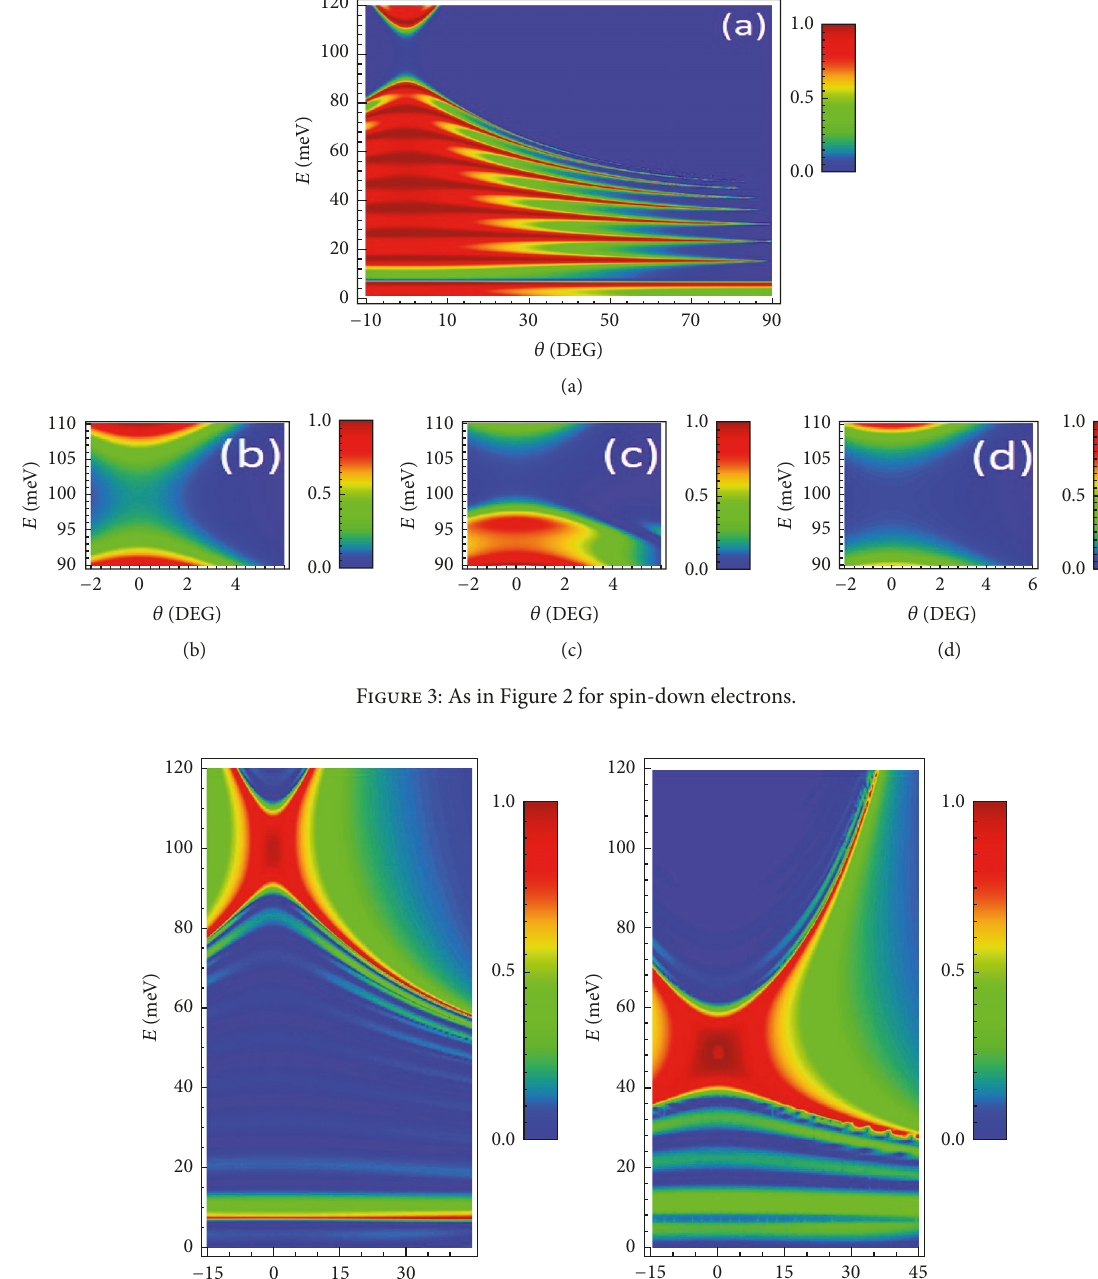
Figure 4: (Color online) (a) Contour plot of the polarization for a single barrier using the results of Figures 2(a) and 3(a). (b) As in (a) with 𝑈 = 50 meV.